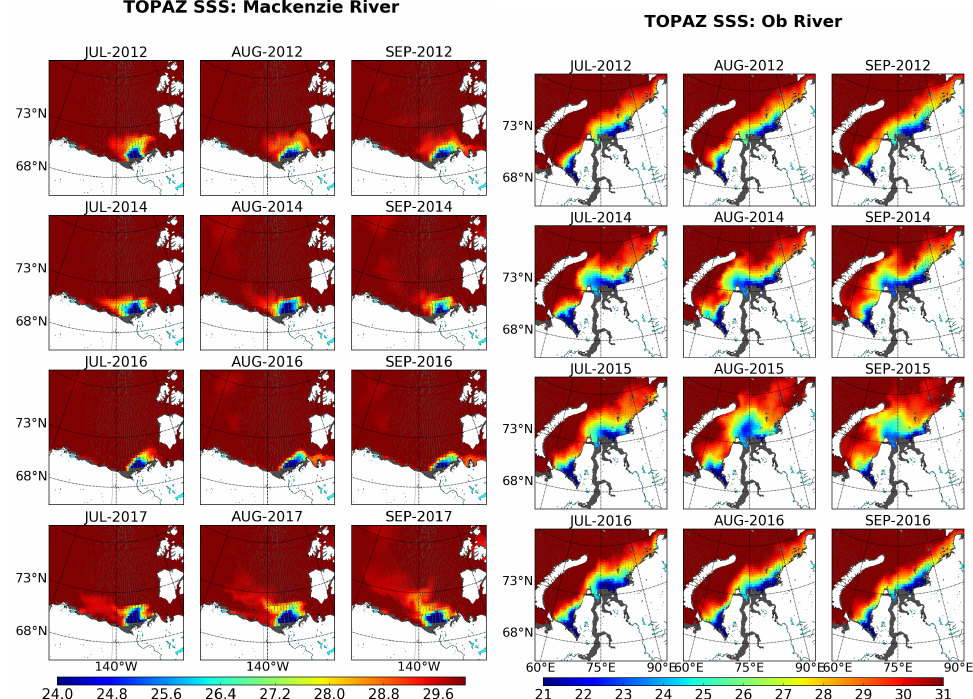
Figure 12. Monthly TOPAZ SSS maps close to the mouth of Mackenzie River: ( left ); and Ob River ( right ).